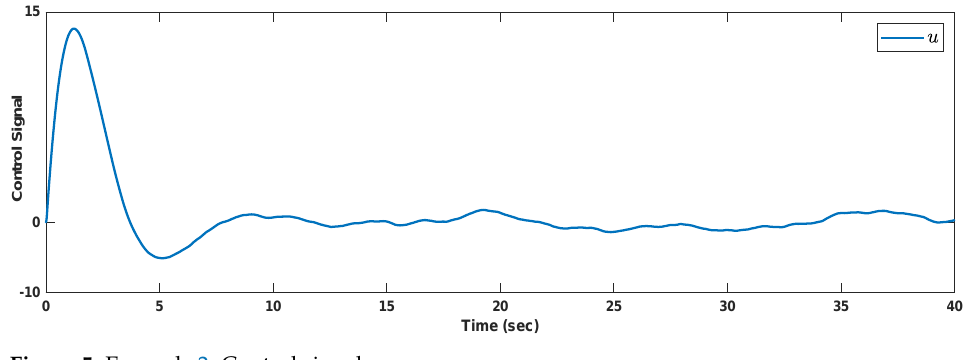
Figure 5. Example 2: Control